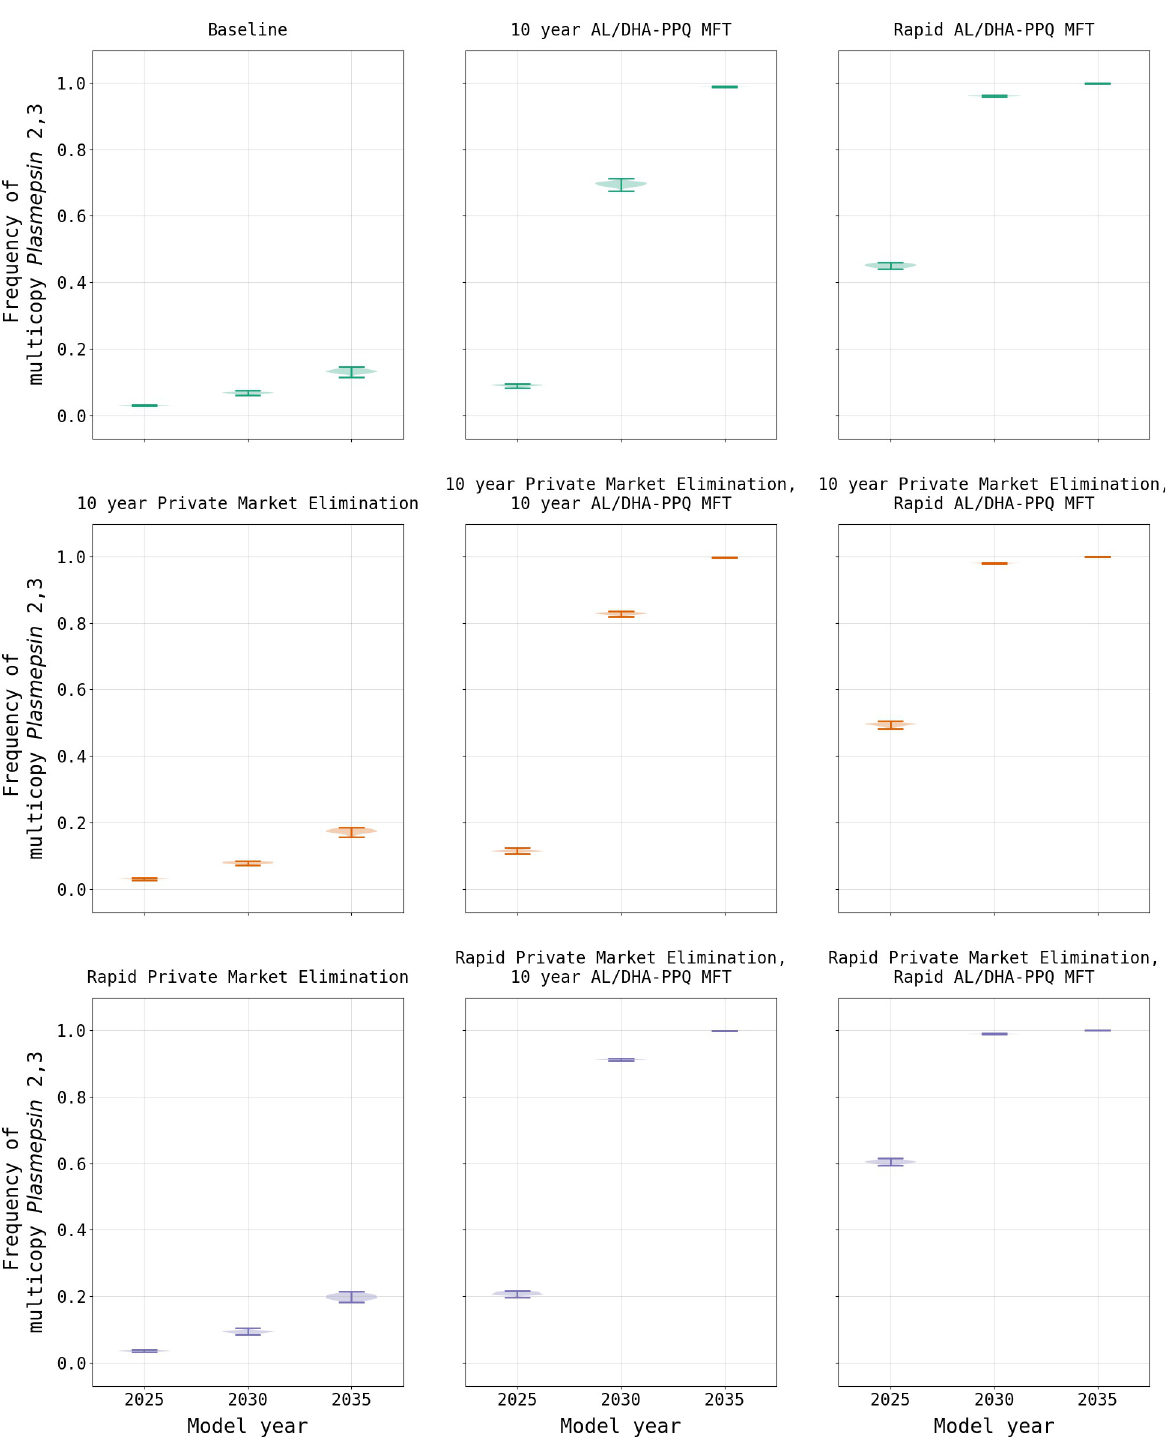
Fig 8. Comparison of the modeled distribution of plasmepsin-2 , 3 double-copy frequency under two drug policies. AL/DHA-PPQ MFT refers to a policy of multiple first-line therapies where AL and DP are deployed equally in the population. Evaluations of MFT and private market elimination are shown for rapid (i.e., immediate) implementation and gradual implementation over a 10-year period. Under policies of private market elimination, there is little effect on DHA-PPQ usage and thus low pressure on plasmepsin-2 , 3 evolution. When MFT is introduced, the usage of DHA-PPQ increases substantially, resulting in rapid selection of double-copy plasmepsin-2 , 3 genotypes.